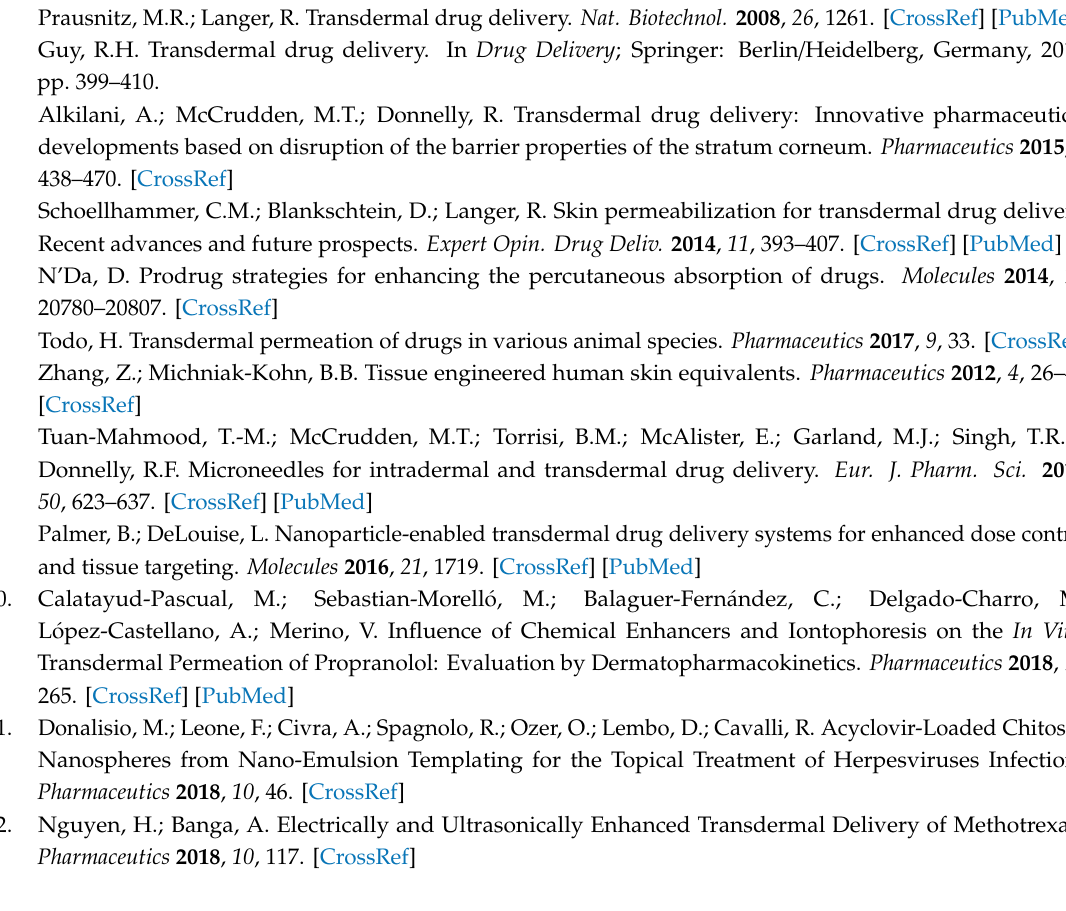
Figure S1: The turbidity of CS, WSCS30, and WSCS90 solutions at pH